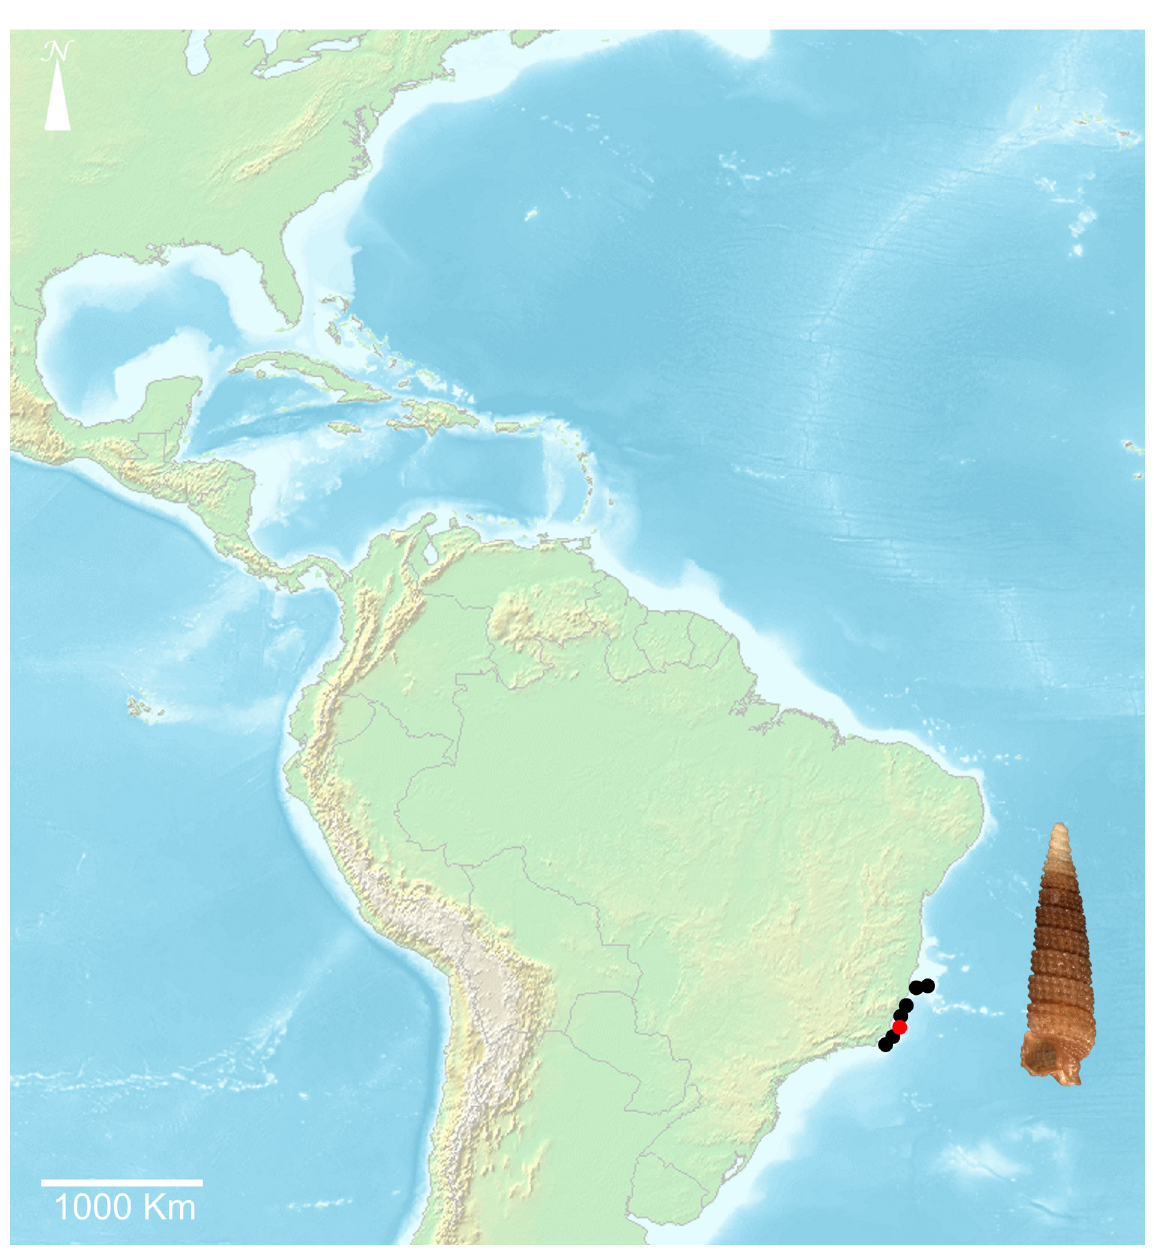
Fig. 41. Distribution map of “ Inella ” leucocephala Fernandes & Pimenta, 2019; red circle = type